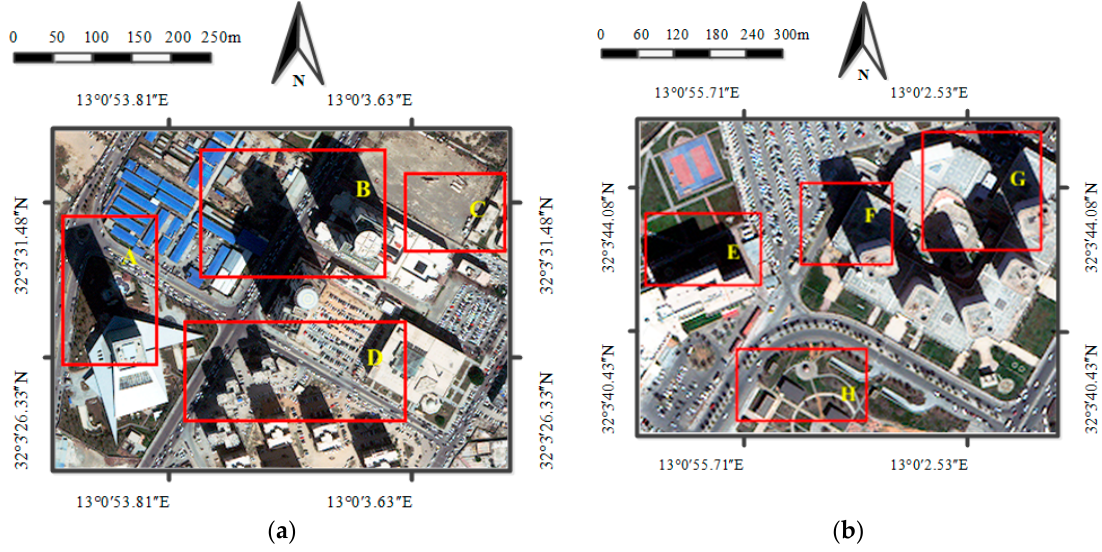
Figure 3. Two test images from WorldView-3 images of Tripoli, Lebanon. ( a ) Tripoli-1. ( b ) Tripoli-2.